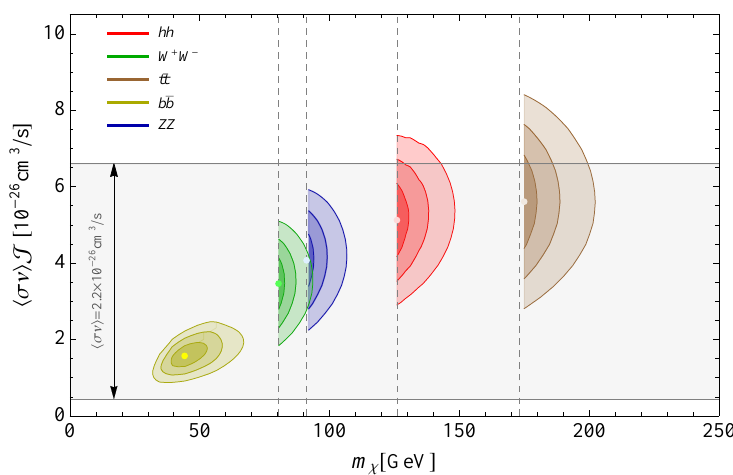
Figure 15: Preferred regions in cross section and mass for DM annihilation to various SM final states, if DM annihilation explains the full Galactic Center excess. Repro- duced from Ref. [ 215 ]